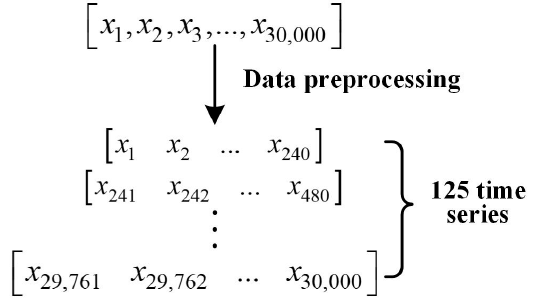
Figure 4. Schematic diagram of data preprocessing for each defect.